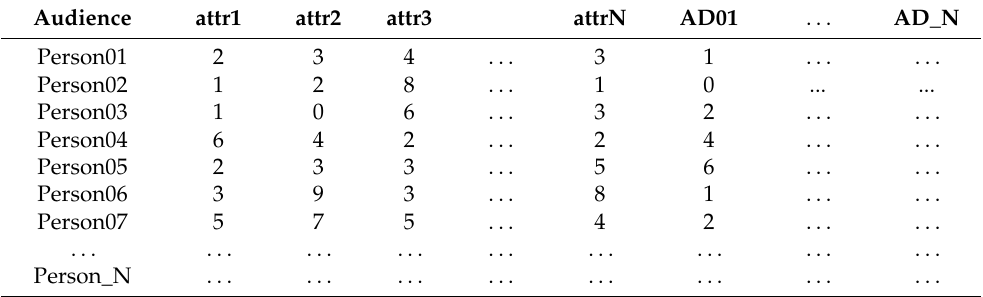
Table 13. Regression analysis using various attributes of all audiences and advertising preference results.